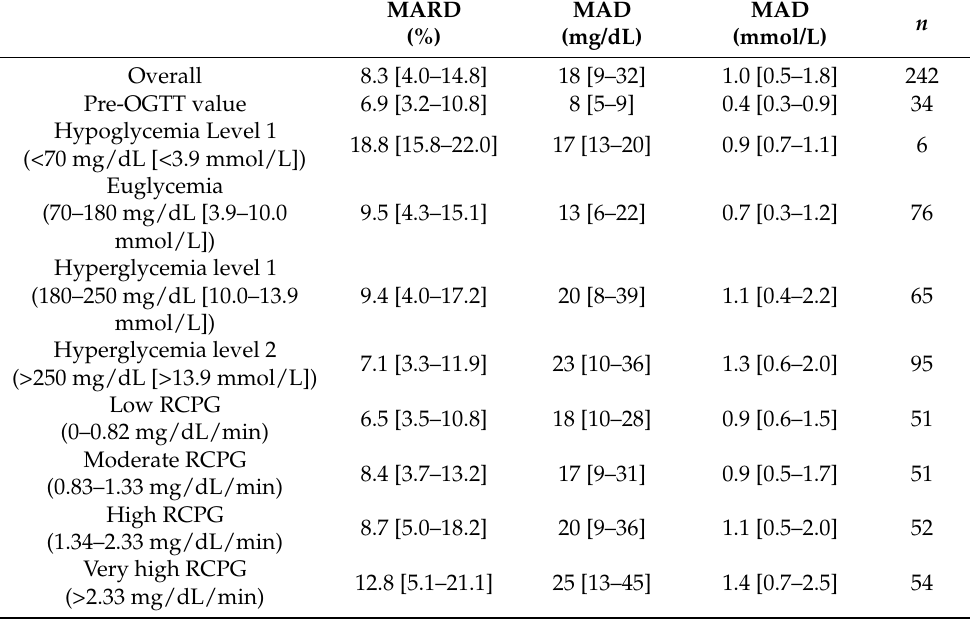
Table 1. Assessment of intermittently scanned continuous glucose monitoring (isCGM) performance by means of median absolute relative difference (MARD) and median absolute difference (MAD). RCPG = rate of change in plasma glucose; n = number of points of comparison; OGTT = oral glucose tolerance test. Values are given as median (interquartile range).